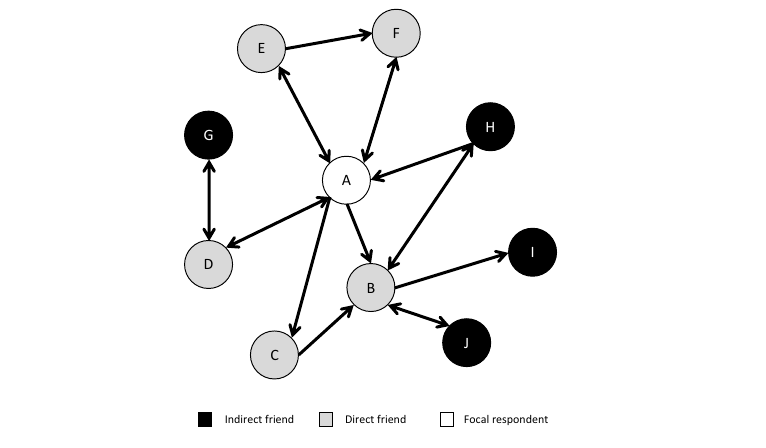
Figure 1 Illustration of direct and indirect friends in a network